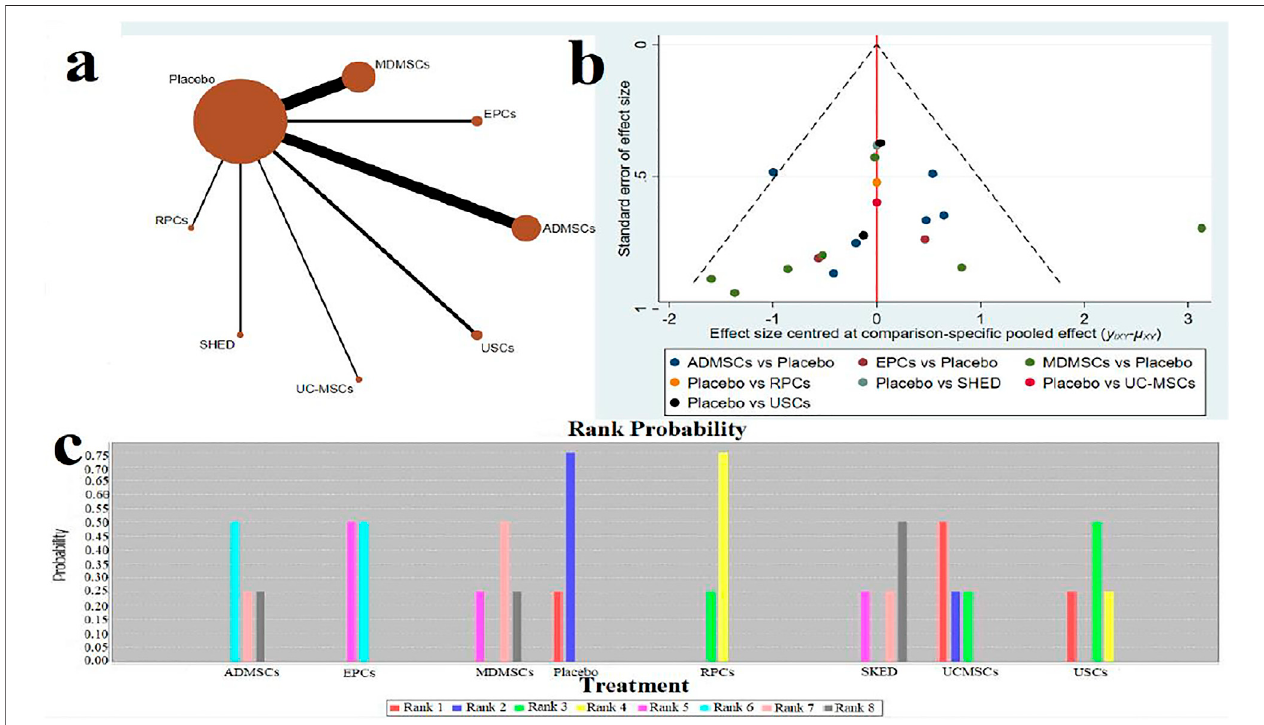
FIGURE 4 | Network Meta-analysis of serum creatinine levels at 7 days after administration (A) Evidence network diagram; (B) The comparison-correction funnel plot; (C) The ranking results).